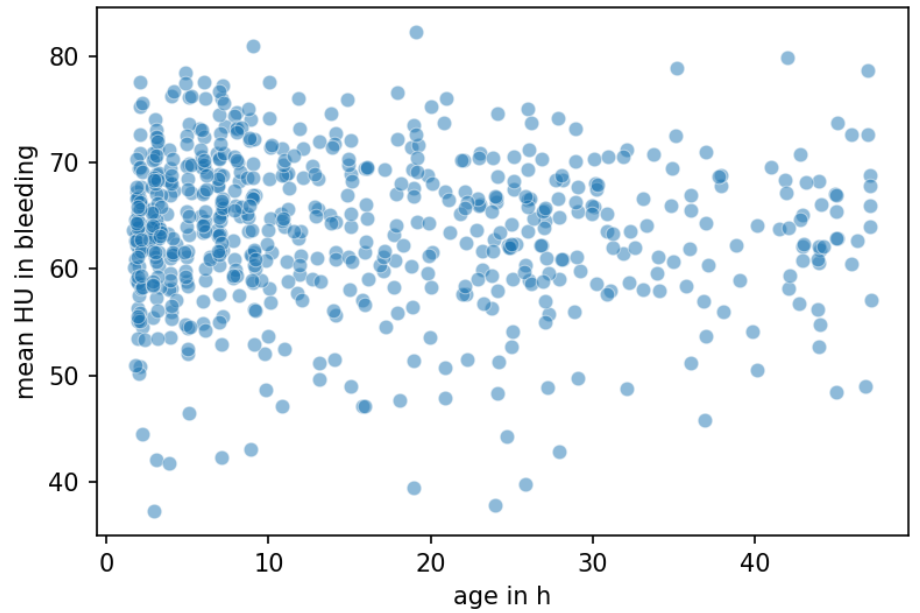
Figure 2. Mean density of intracerebral hemorrhage on admission imaging and association with symptom onset. HU = Hounsfield Units, age in h = time since onset in hours.